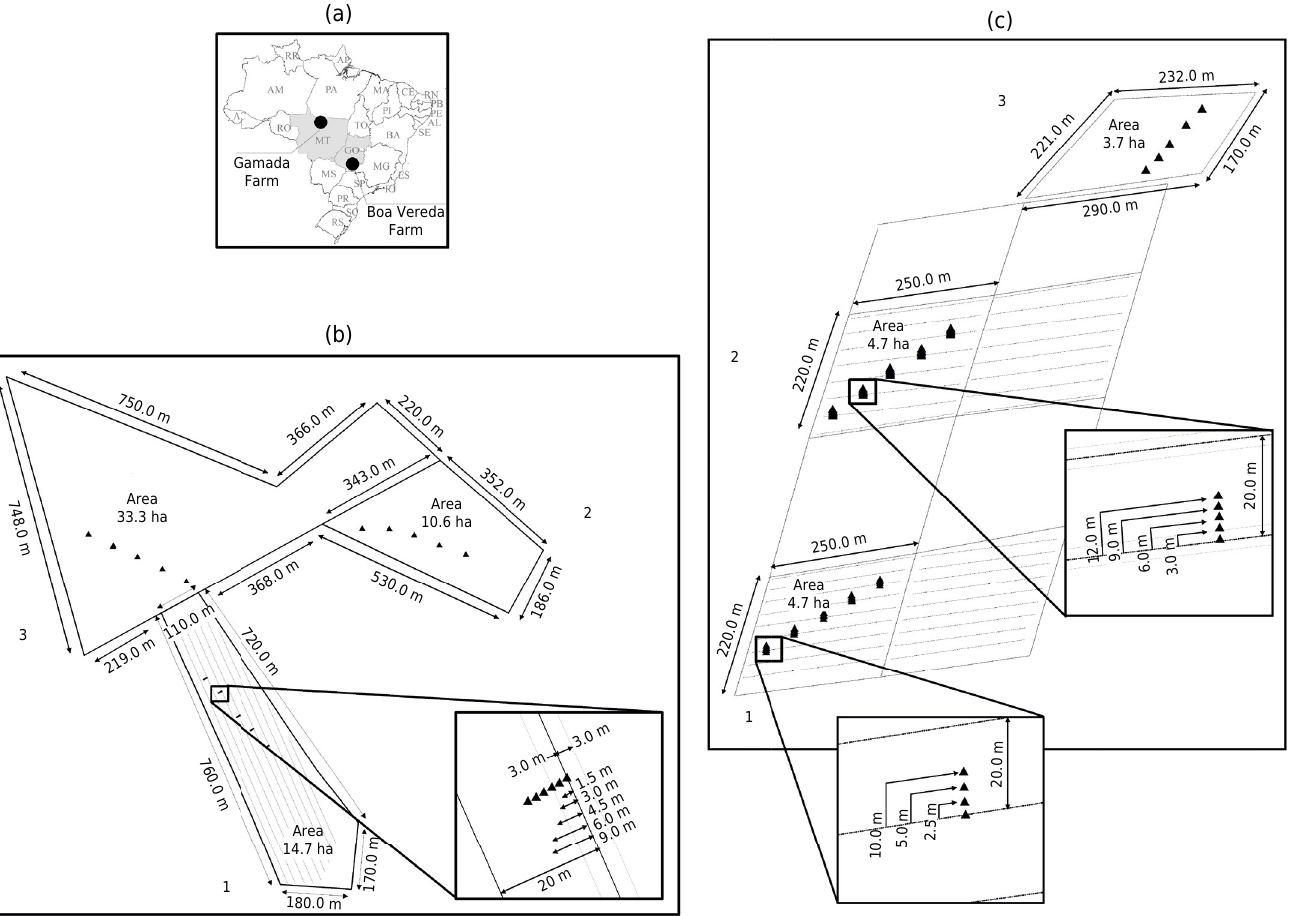
Figure 1. (a) Location of the studied areas; (b) Boa Vereda Farm: 1. area under iCLF with three eucalyptus rows, 2. area under degraded pasture, 3. area under recovered pasture; (c) Gamada Farm: 1. area under ICLF with single eucalyptus row, 2. area under ICLF with triple eucalyptus rows, 3. area under degraded pasture. Source: Assis et al.